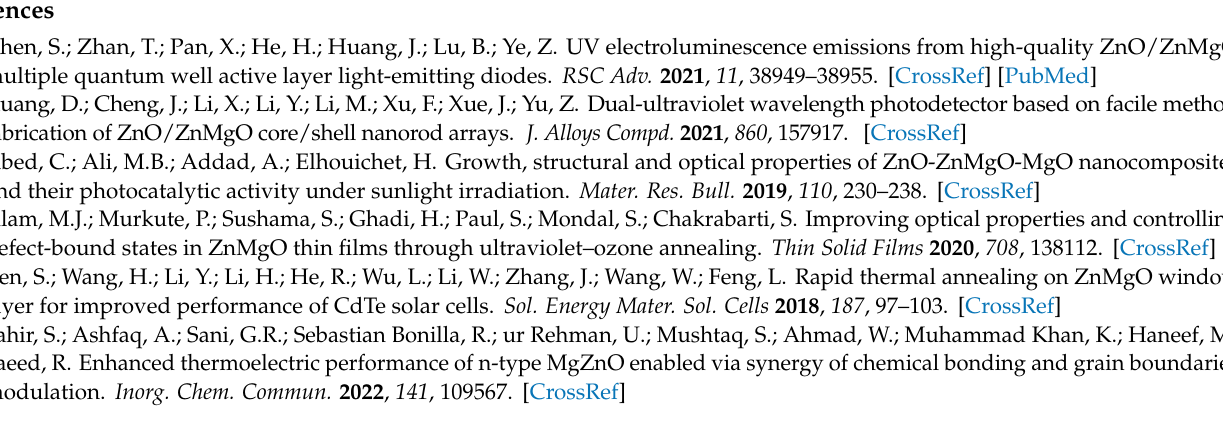
GPAW (text, 1 Table and 1 Figure); S2: Band gaps for the different structural models obtained from CRYSTAL and GPAW (text and 1 Figure); S3: Optical properties of rocksalt ZMO with modified electronic structures (text and 1 Figure). References [49] are cited in the Supplementary